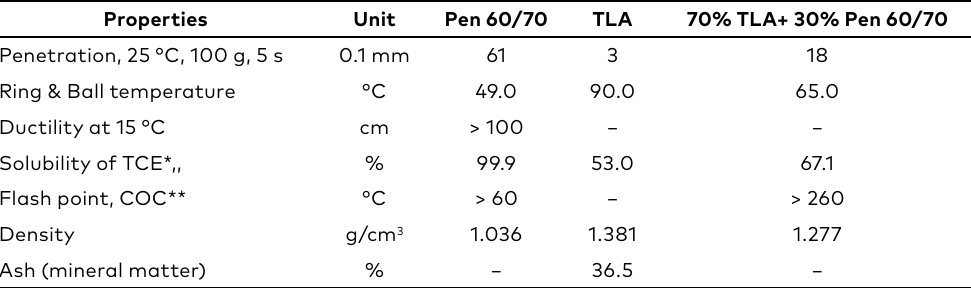
Table 1. Properties of asphalt